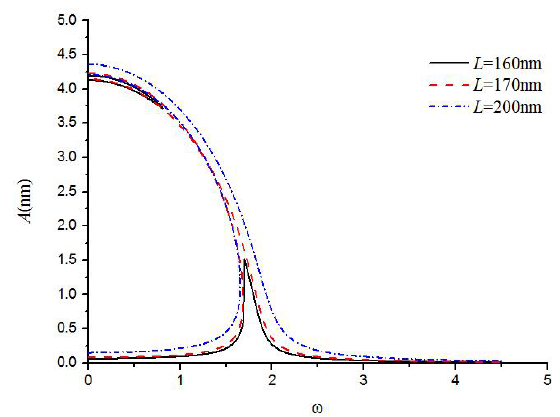
Fig. 4. The effect of length to the amplitude-frequency response